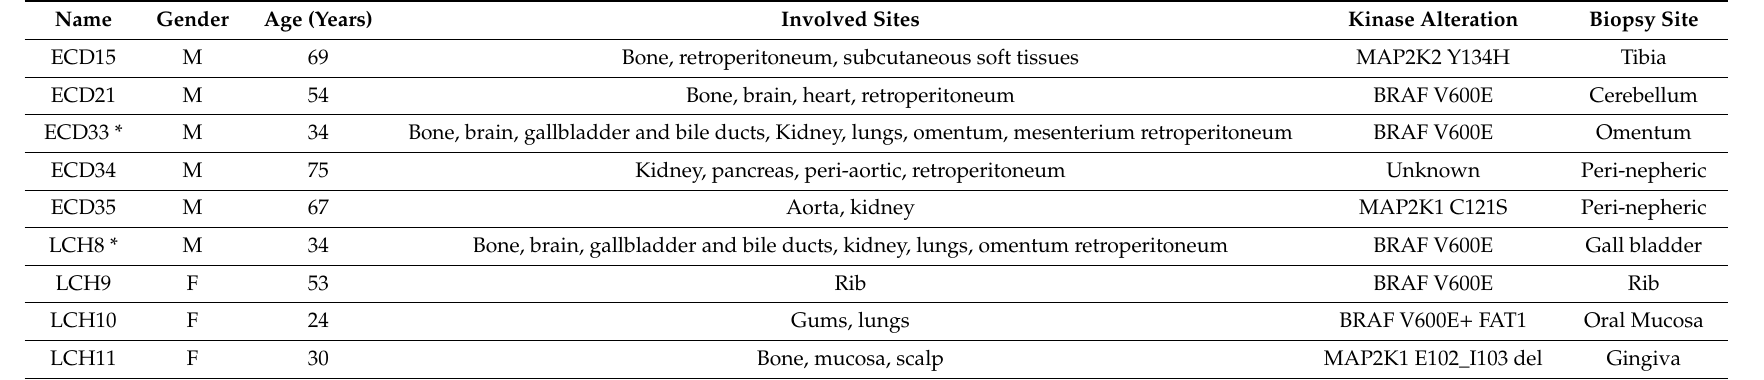
Table 2. ECD and LCH patient characteristics (FFPE samples from lesion